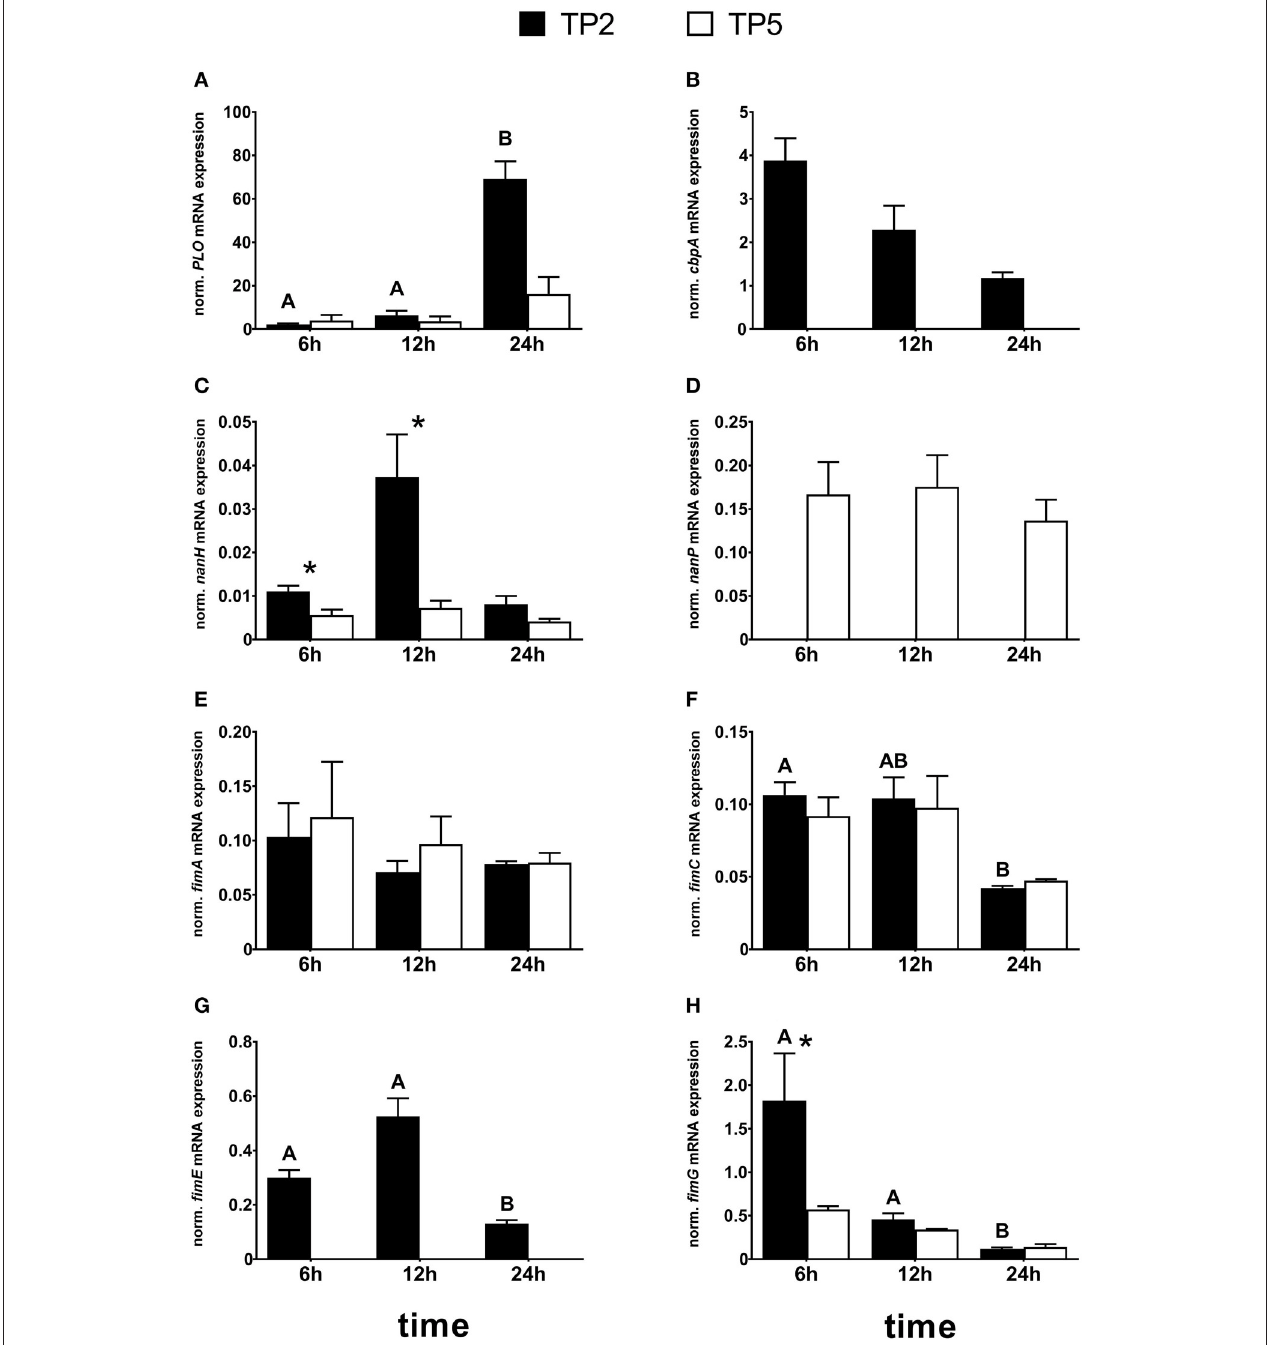
FIGURE 3 | Normalized mRNA expression of the virulence factors: (A) PLO , (B) cbpA , (C) nanH , (D) nanP, (E) fimA , (F) fimC , (G) fimE , and (H) fimG in TP2 and TP5 cultured in BHI supplemented with 5% HI FCS up to 24 h. The bars show means ± SEM of mRNA expression values from different inocula ( n = 3). Asterisks above the bars indicate significantly different mRNA expression ( P < 0.05) between the two strains at the same time point. Different capital letters (A,B) above the bars indicate a significant difference within TP2 between different time points ( P < 0.05).